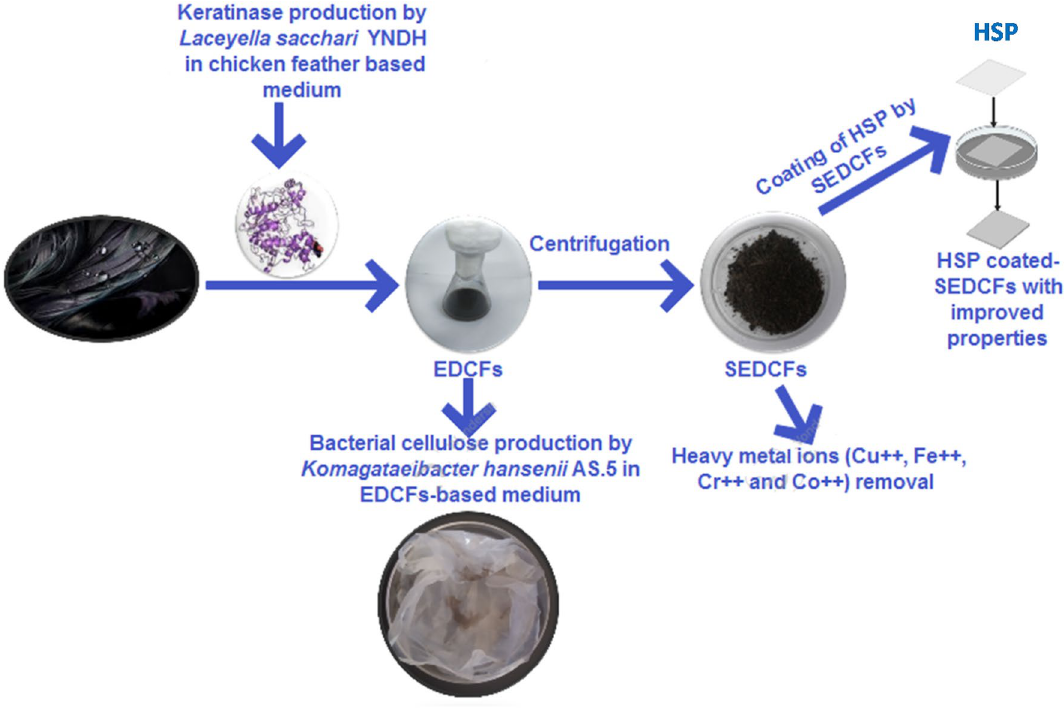
Figure 1. Schematic diagram shows benefiacil multipuropses utilization of bio-hydrolyzed CFs waste liquid lyaste and sludge.